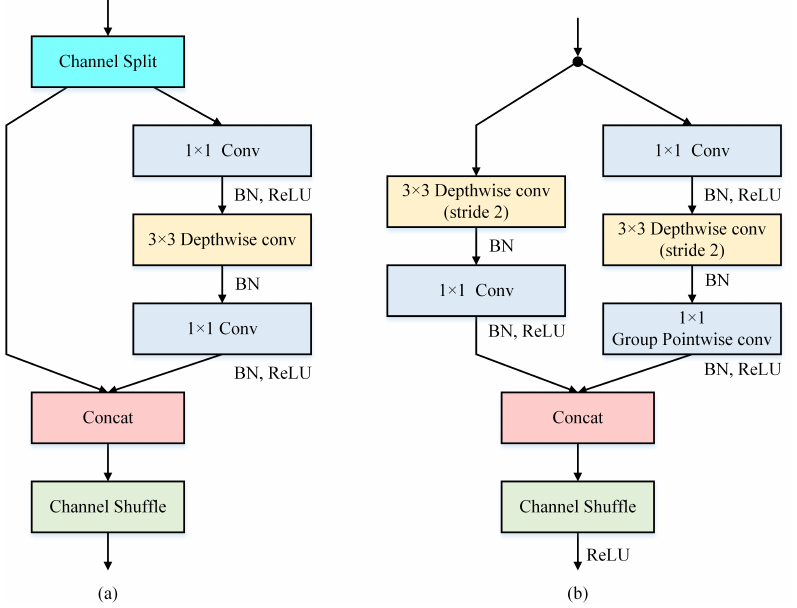
Figure 34. ( a ) ShuffleNetV2 unit. ( b ) ShuffleNetV1 unit with stride = 2 (down sampling, 2).